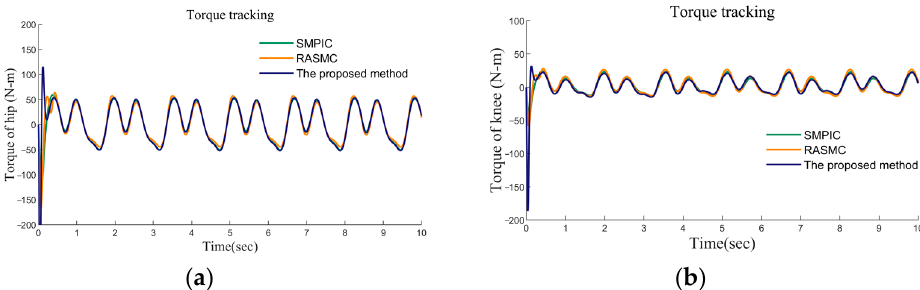
Figure 14. The time history of the joints. ( a ) The time history of hip torque under case 2 condition and ( b ) The time history of knee torque in case 2 condition.